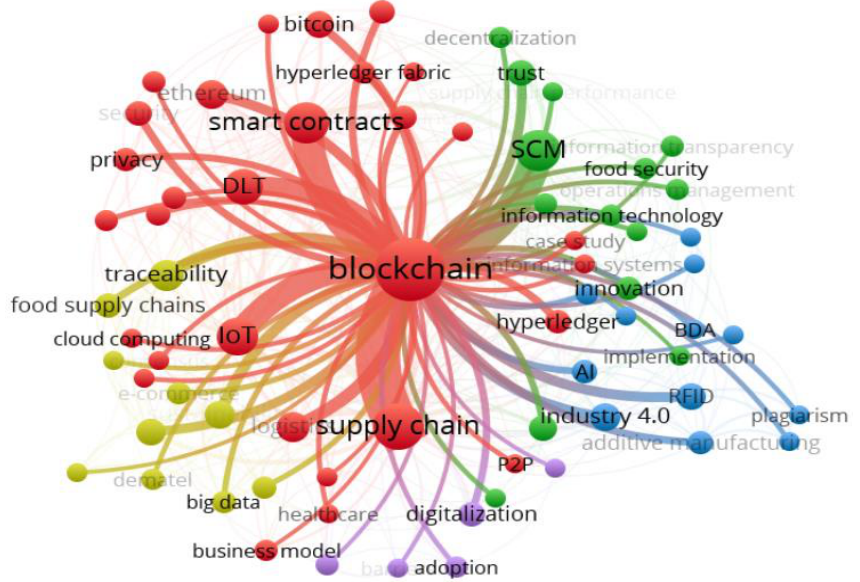
Figure 5. Keyword co-occurrence network. Table 9. Top ten ranked keywords based on frequency in the cluster. Blue Cluster Yellow